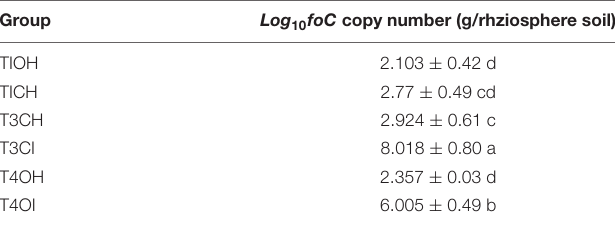
TABLE 1 | Tomato rhizosphere Fusarium oxysporum pathogen density dynamics from seedling phase (March) to harvesting phase (August) in 2019 during the field experiment ( N =